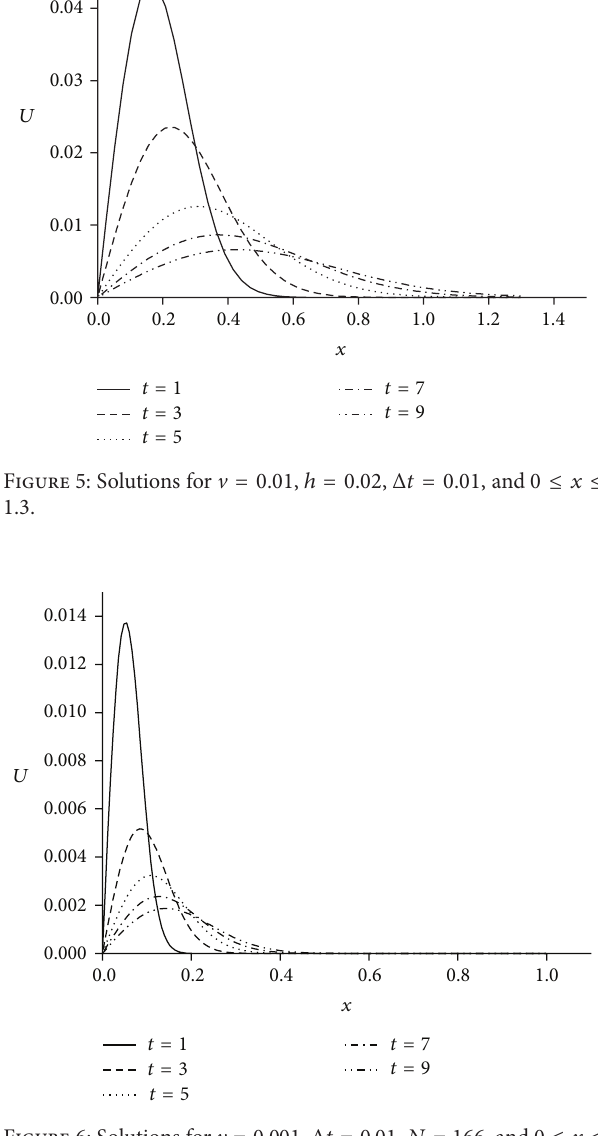
Figure 6: Solutions for V = 0.001 , Δ𝑡 = 0.01 , 𝑁 = 166 , and 0 ≤ 𝑥 ≤ 1 .